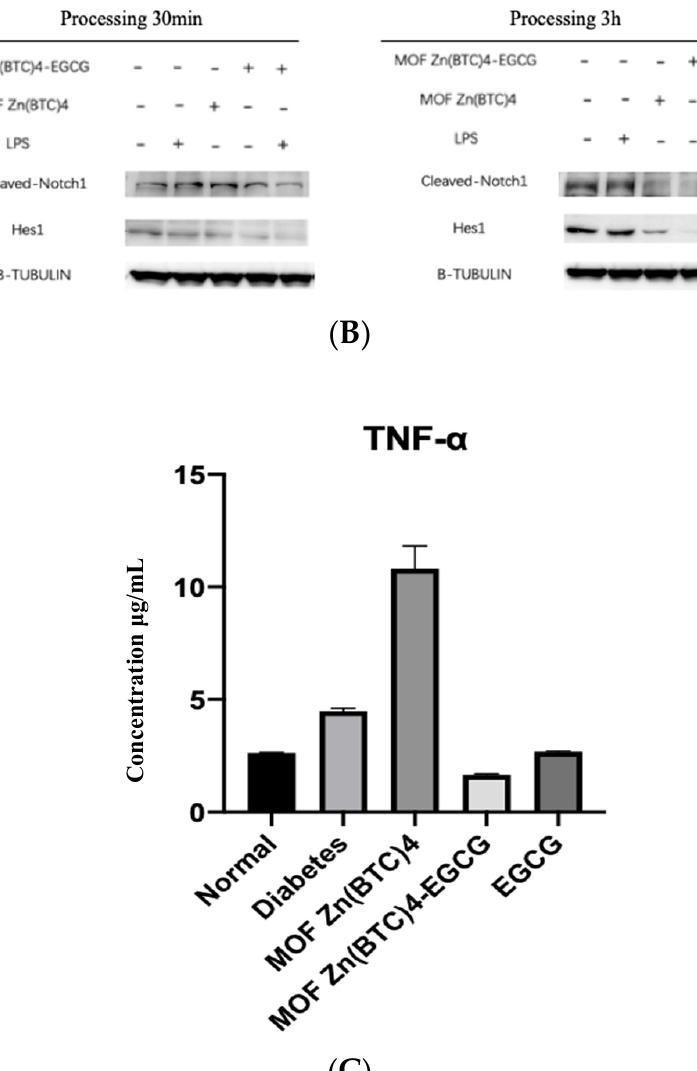
Figure 7. Effect of EGCG @ MOF Zn(BTC) 4 on Notch protein expression and inflammatory factors in macrophages. ( A ) Effect of EGCG@MOF Zn(BTC) 4 on Notch protein expression at different time points; ( B ) Effect of EGCG@MOF Zn(BTC) 4 on Notch protein expression at different time points; ( C ) Effect of EGCG@MOF Zn(BTC) 4 on inflammatory factor levels.